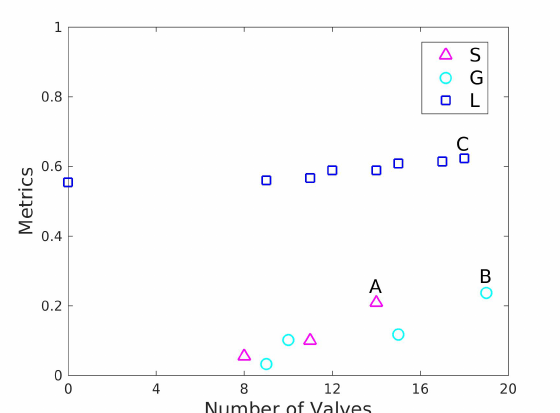
Figure 9. Pareto front of solutions for MLN network obtained with the three studied PIs. Legend: